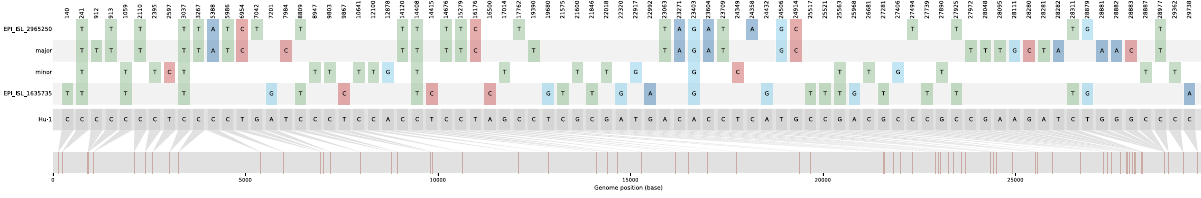
Fig. 6 Putative Alpha/Iota variant recombinant and the nucleotide variation present in the major, minor, and reference strains. The distribution of the nucleotide variation found in the major, minor, Iota (B.1.526; EPI_ISL_1635735), and single putative recombinant (EPI_ISL_2965250) strains relative to the reference genome (Wuhan Hu-1; bottom gray